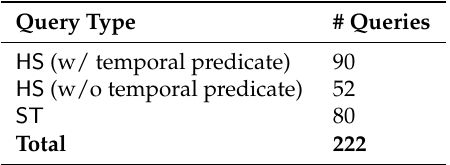
Table 3. Composition of the test workload used for the performance